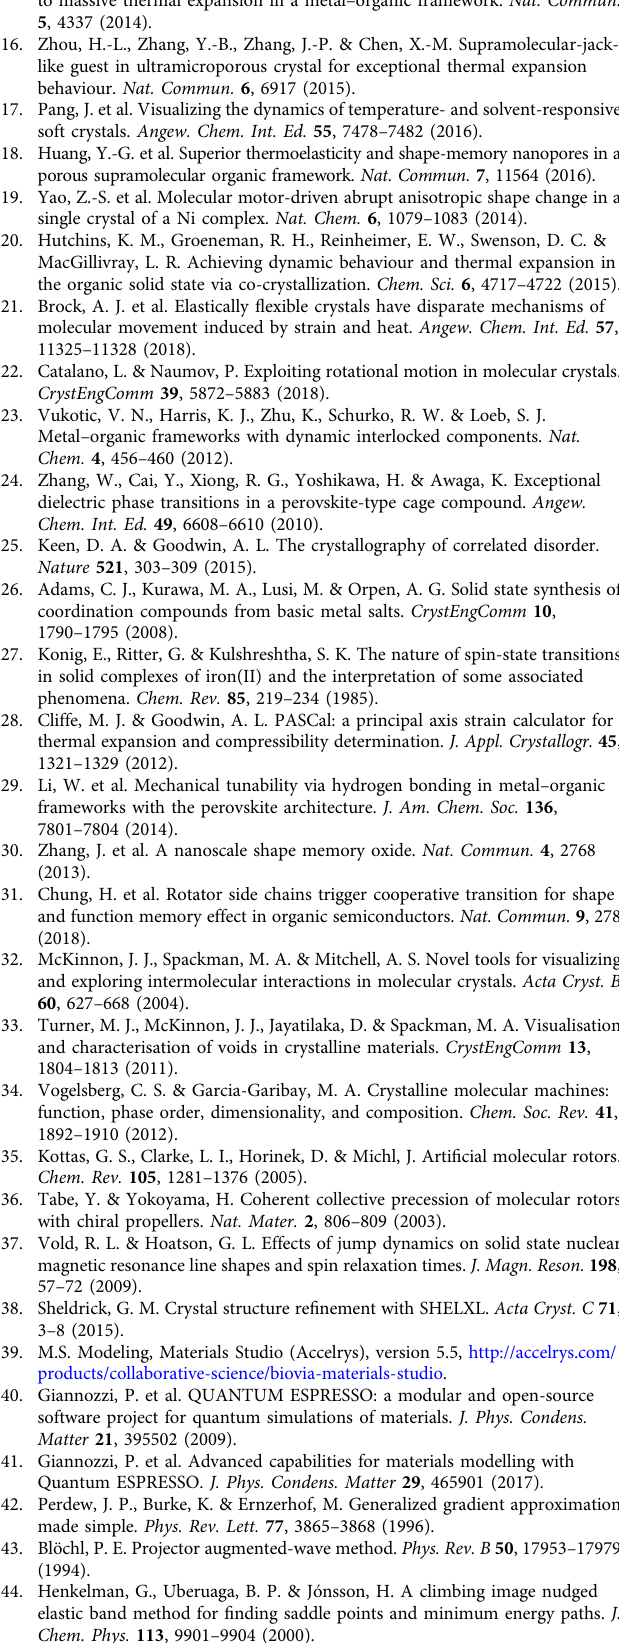
algorithm method based on the trust radius procedure was used for geometry optimizations. The climbing-image nudged elastic band method 44 with the